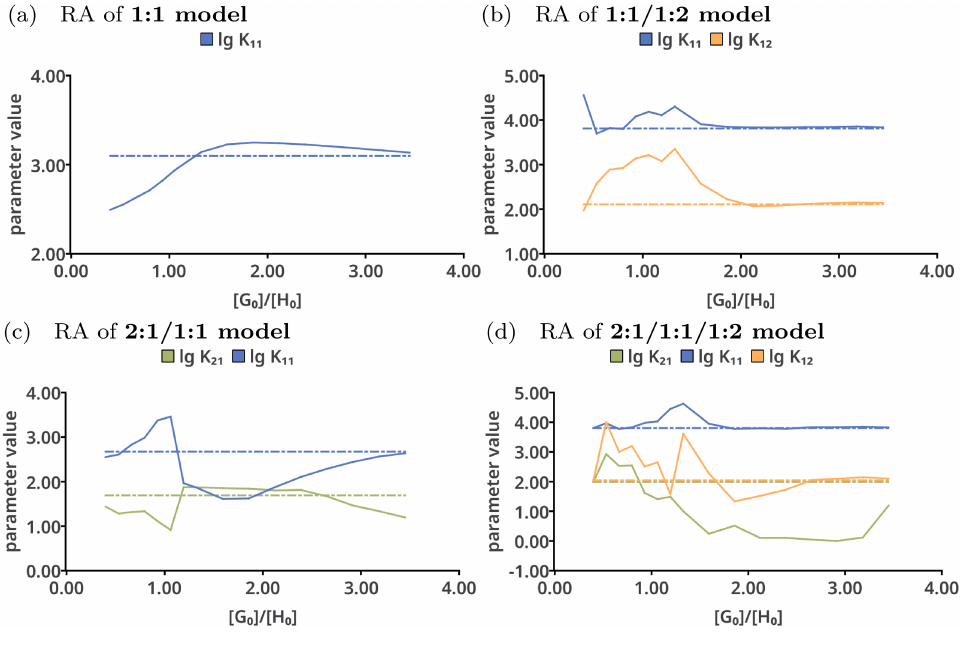
Figure 7 Results of the Reduction Analysis for each tested model. The solid lines indicate the optimised parameters if the titration was only performed up to the ratio according to the current x value. The dot- ted lines indicate the optimised parameters after complete titration. In the chart (A) ( 1:1 model ), the de- viation from the fitted value upon removing the last data point can be observed. Although scaled differ- ently, the optimised parameters of the 1:1/1:2 model remain constant above a ratio of 2.0 (B). The analysis shown in (C) and (D) with wrong models indicate more deviation of the refitted parameter compared to the originally optimised one, except for lg K 11 in the 2:1/1:1/1:2 model , which behaves similar to lg K 11 in the 1:1/1:2 model . Full-size DOI: